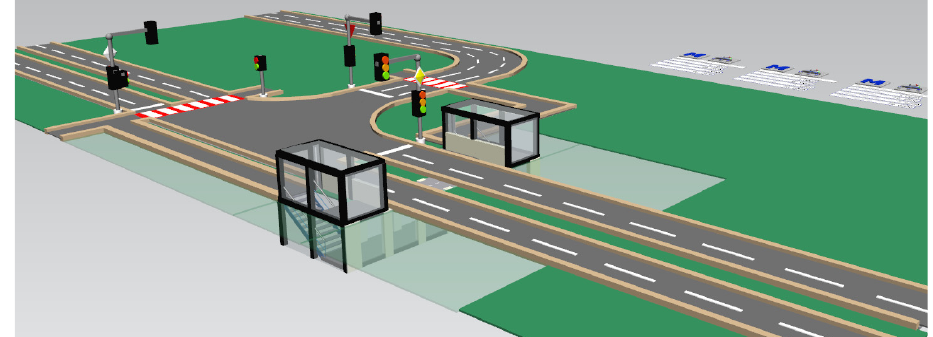
Figure 14. 2D intersection model.